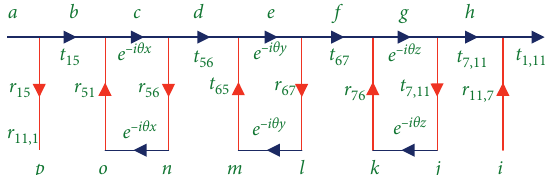
Figure 2: SFG representation for the optical filter after using single path